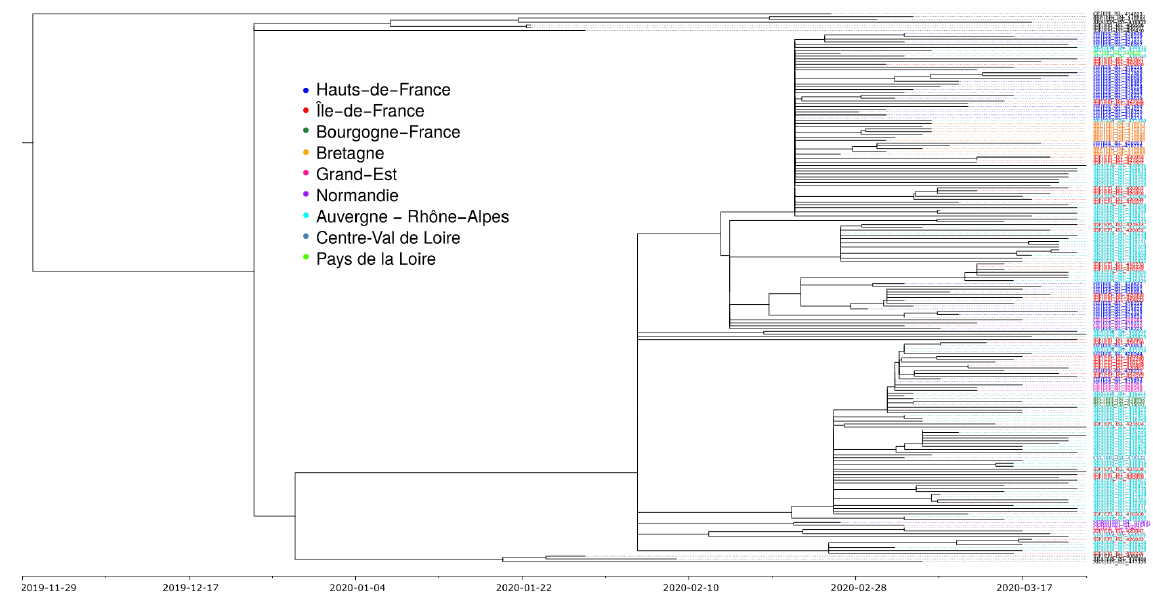
Figure 1 – Phylogenetic structure of 196 SARS-Cov-2 genomes from France. Color shows the French region of sampling. Sequences in black were removed from the anal- ysis because they fall outside the main clade corresponding to the epidemic wave. The phylogeny in a Newick format is available in the online Supplementary